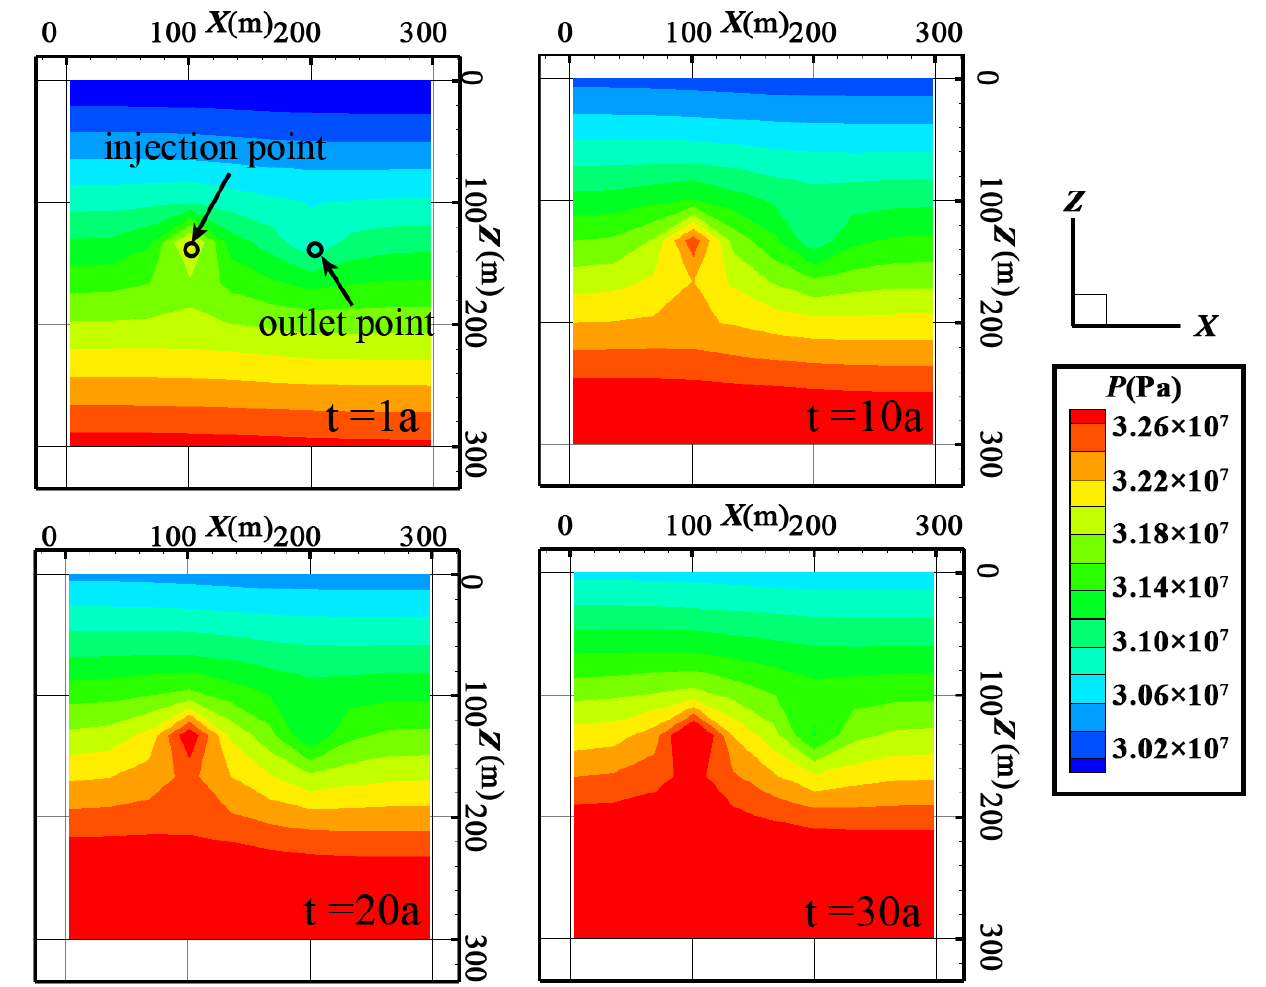
Figure 18. Pressure distribution for the conventional double vertical wells.